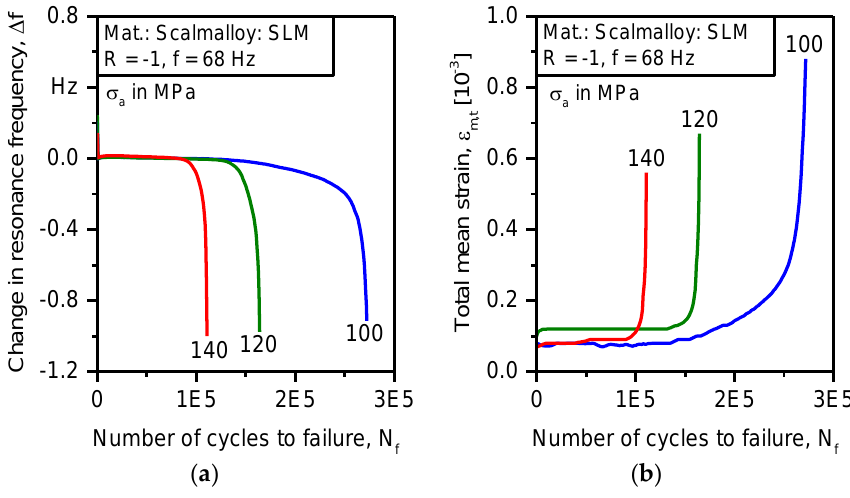
Figure 13. Specimen response of resonance testing for batch D (Scalmalloy ® SLM): ( a ) Change in resonance frequency; ( b ) Total mean strain.